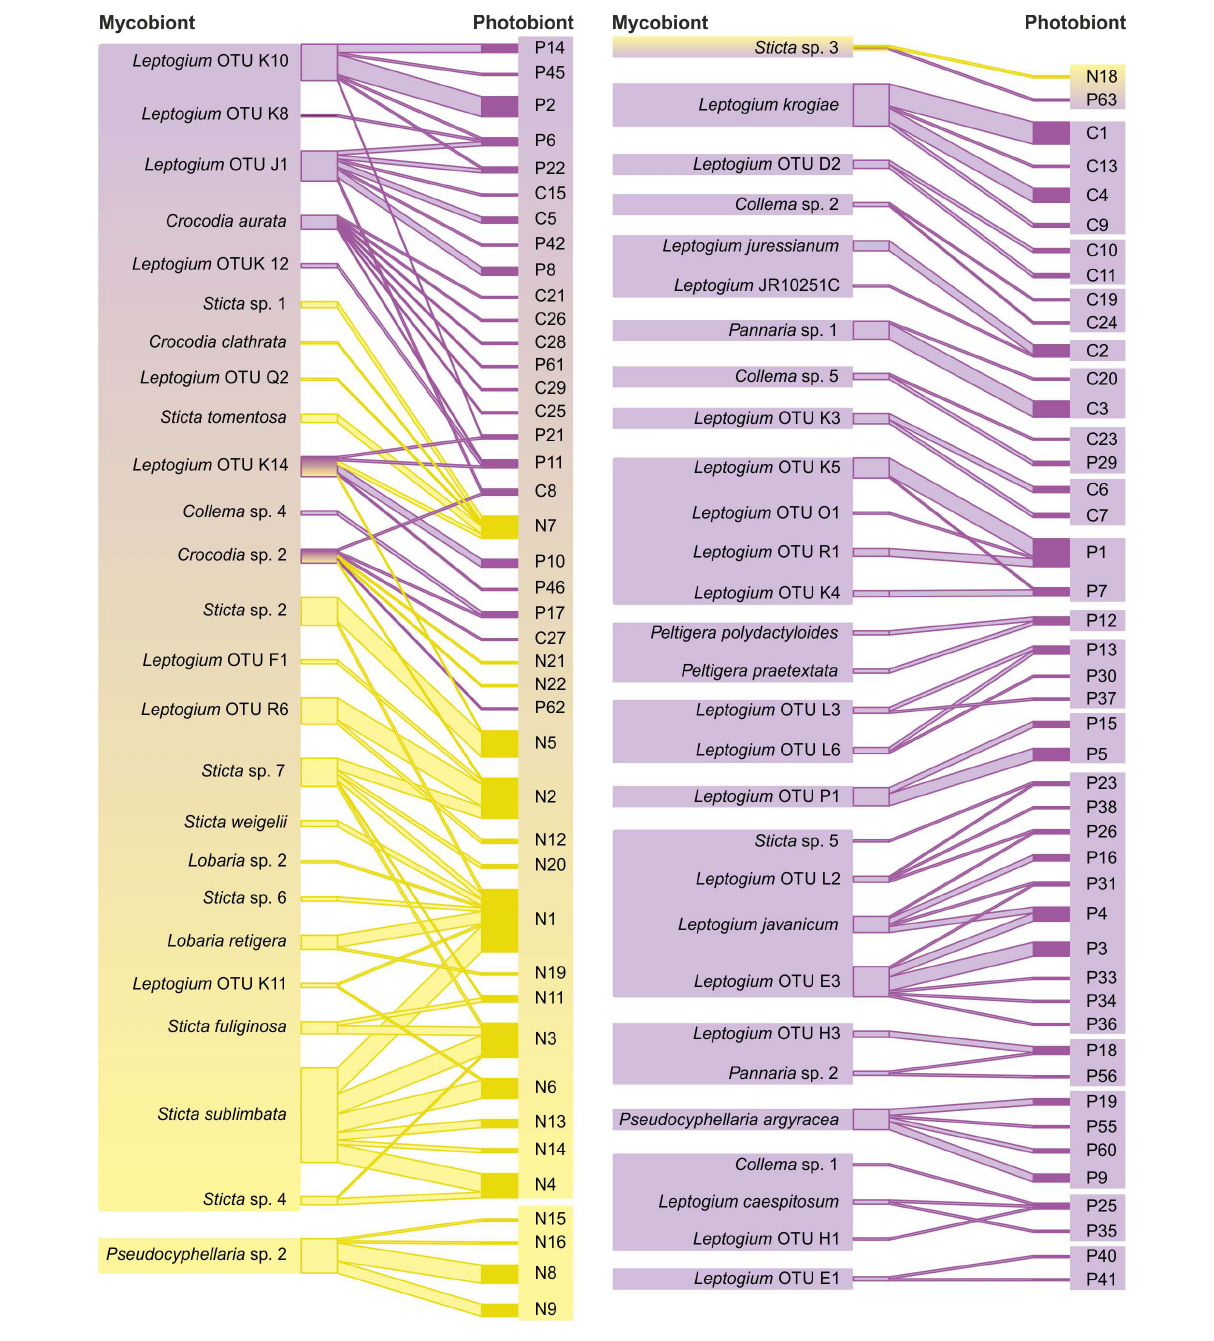
were not significantly nested (RN = 0.10). In the Peltigera guild, the mycobiont interactions were not significantly nested (RN = − 0.11), but the cyanobiont interactions were ( p < 0.05, RN = 0.33). Furthermore, the interaction network of the Peltigera